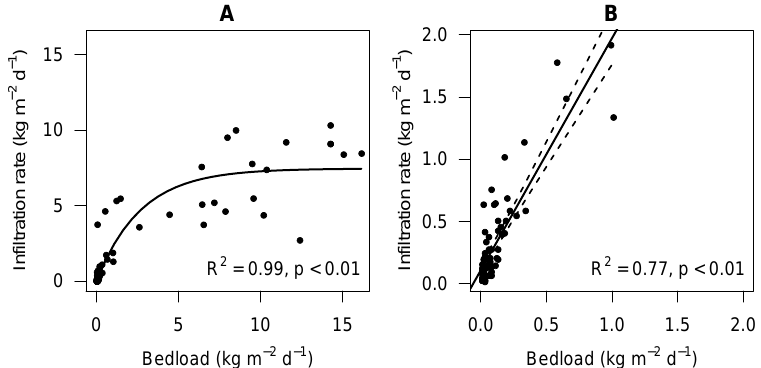
Fig. 9. Relationship between infiltration rate of fine sediment measured with sediment baskets and bedload measured with bedload traps at site A. (A) : all data with a nonlinear regression line, R 2 and p were calculated after Zuur et al. (2009); (B) : linear regression for data with infiltration rates smaller 2kgm − 2 d − 1 , dashed lines are the 95% confidence intervals.